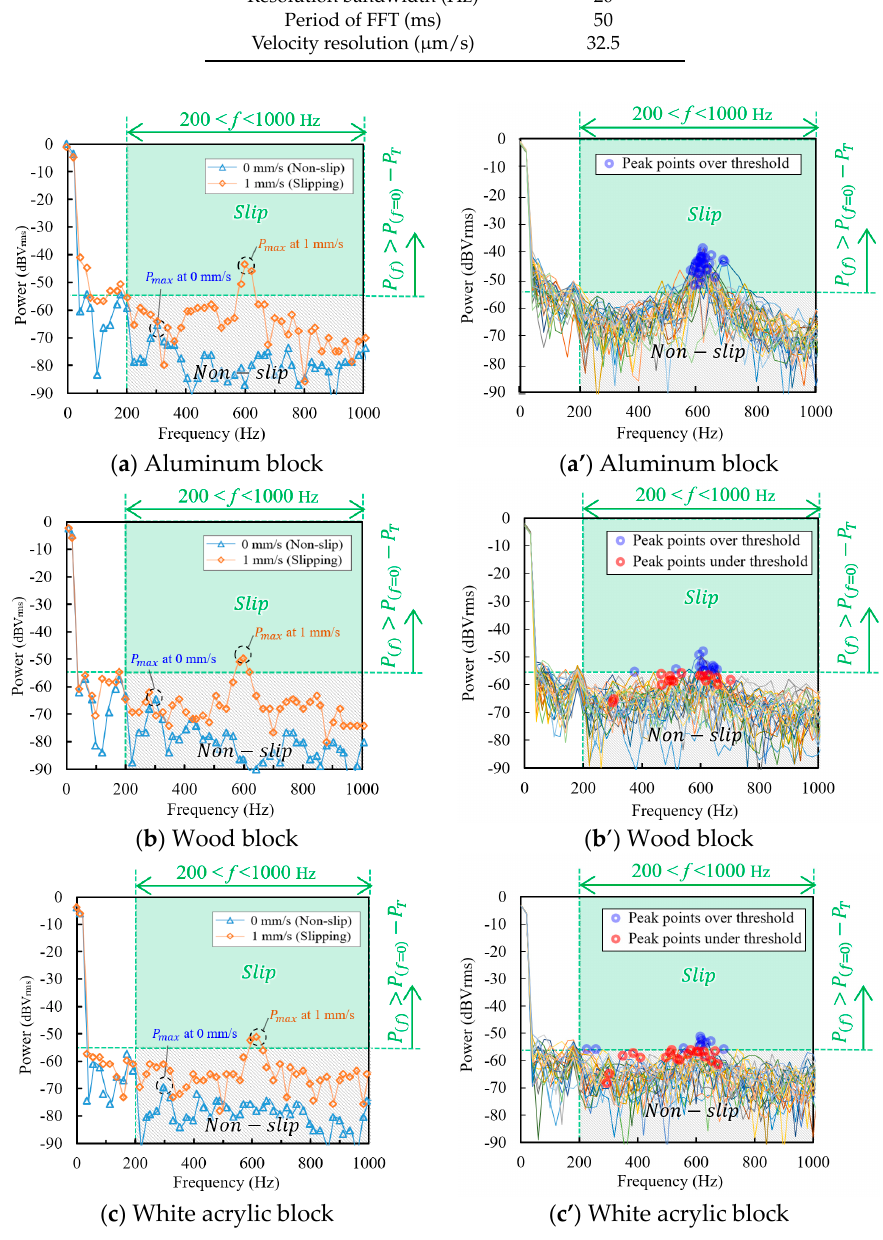
Figure 8. Examples of power spectra of the μ -LDV output in non-slip and slipping at 1 mm/s. The green-colored area indicates the region that fulfills slip determination condition. The control system judges slipping when P max(200<f<1000) is in the green-colored area: ( a ) Aluminum block; ( b ) Wood block; ( c ) White acrylic block. ( a’ – c’ ) show 30 continuous power spectra of each block measurement during slipping. The P max(200<f<1000) of each power spectrum is indicated as a blue circle if the power is higher than P (f=0) − P T (Equation (3) is ‘true’), or as a red circle if the power is lower than P (f=0) − P T (Equation (3) is ‘false’).